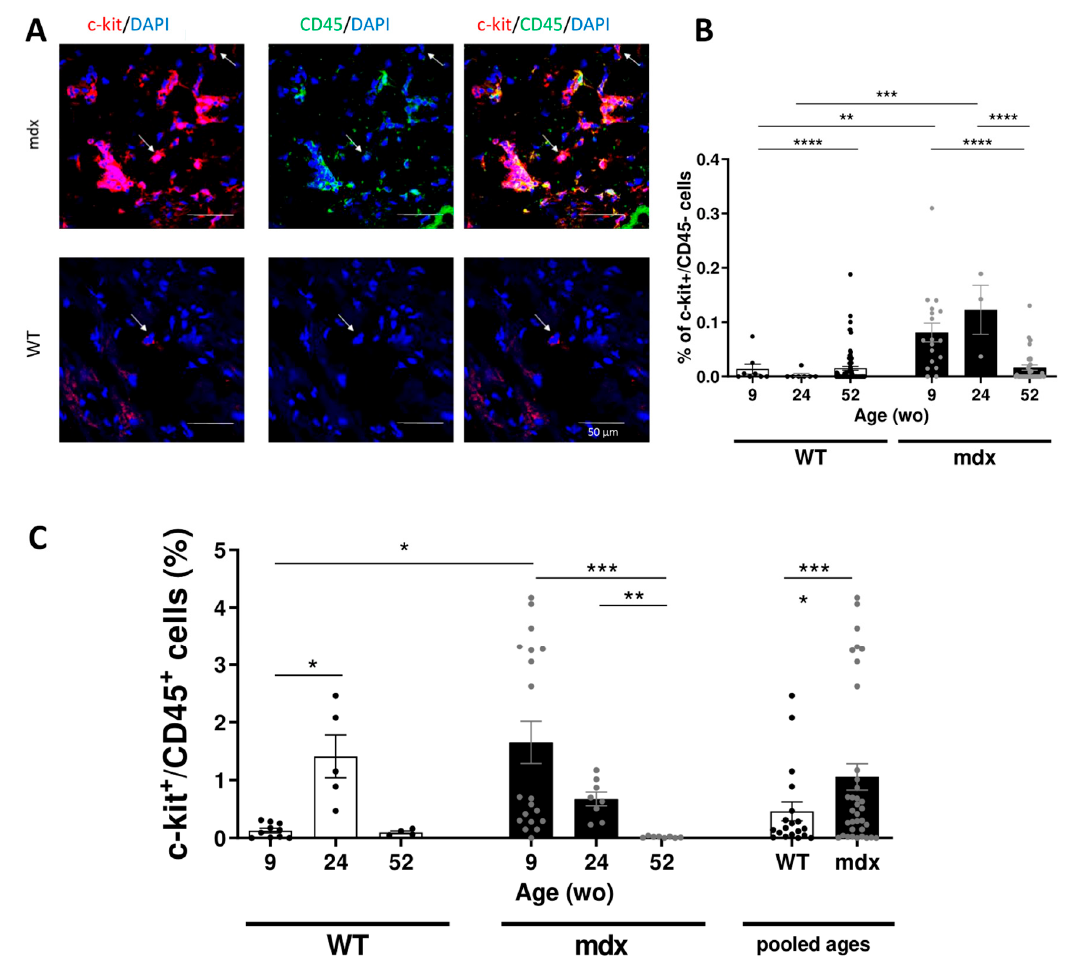
Figure 2. Recruitment of CVPCs in mdx hearts. ( A ) Representative histological analysis images of c-kit and CD45 immunolabeling. CVPCs were evaluated only as cells with positive signal for c-kit (red) and without signal for CD45 (green). Individual cells with these criteria are identified by arrows on the images. C-kit + /CD45 − cells were evaluated as mast cells. Scale bars: 50 µ m. ( B ) Bar graphs showing the percentage of c-kit + /CD45 − cells relative to the total number of cells in WT (open bar and black dots) and mdx (black bar and grey dots). Data are shown as mean ± SEM ( n = 3–20 sections per group; three animals were analyzed for the 9 wo and 52 wo groups, and two animals were analyzed for the 24 wo group). The statistical significance was calculated by two-way ANOVA and Tukey’s multiple comparison test (* p < 0.05, ** p < 0.01, *** p < 0.001). ( C ) Bar graphs showing the percentage of inflammatory mast cells (c-kit + /CD45 − ) at different ages in WT (white bars and black dots) and mdx (black bars and grey dots) hearts. These mast cells were evaluated from the labeled sections shown in Figure 2A. Data are shown as mean ± SEM. Statistical significance was calculated by Kruskal–Wallis test and Dunn’s multiple comparisons for each individual age group of WT and mdx hearts and by Student’s t-test for pooled age groups (* p < 0.05, ** p < 0.01, *** p < 0.001, **** p <